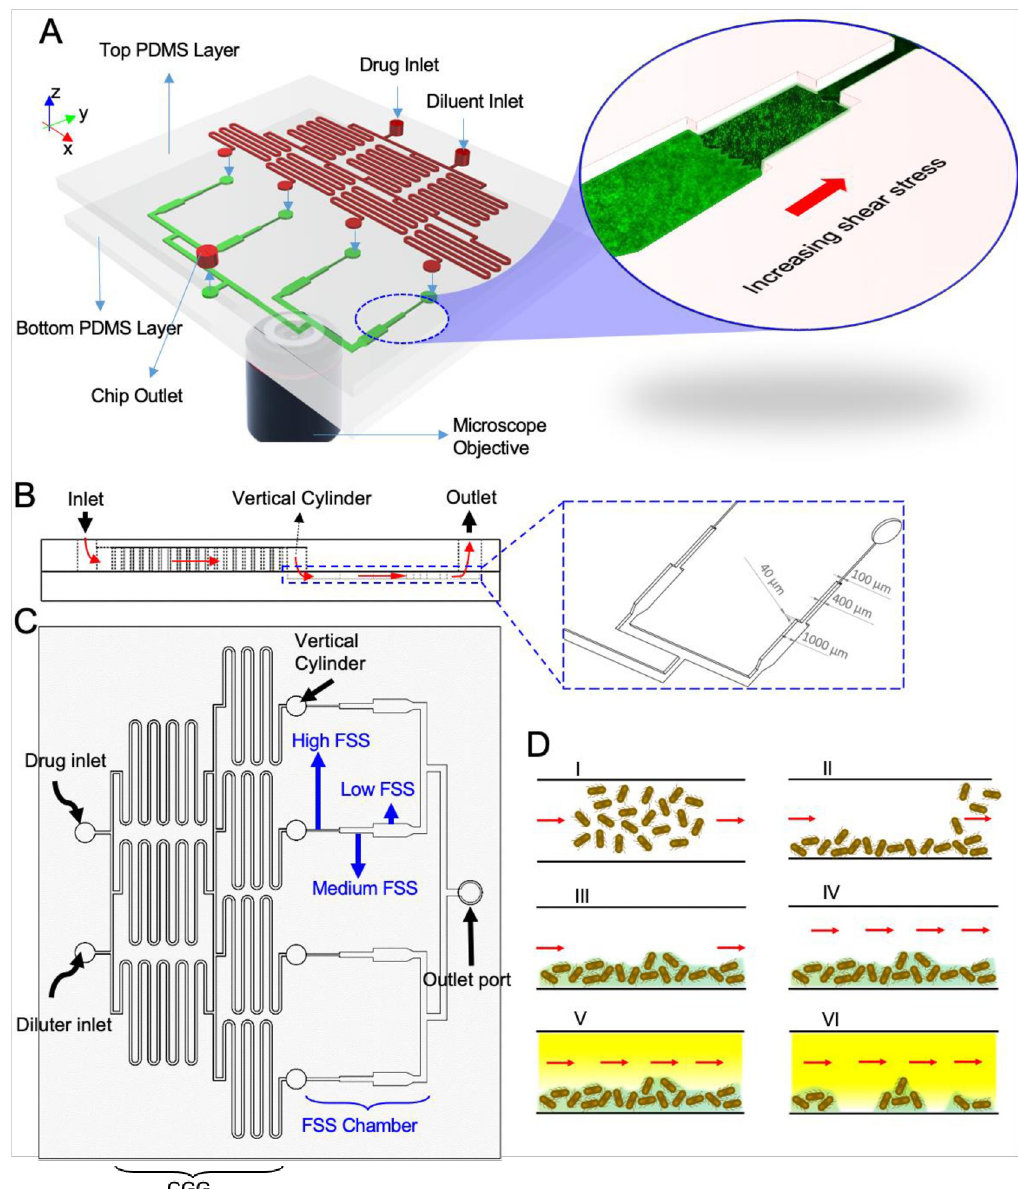
Fig 1. Integrated microfluidic platform allows investigation of combinatory effects of chemical and fluid shear stress (FSS). Ports and channels on the top layer are colored in red. Microchambers and collector channels on the bottom layer are colored in green. Vertical cylinders mediate the connection between the channels on the top and the bottom layer A) Schematic representation of the 2-layer physicochemical analysis biofilmchip (2PAB) B) Cross-sectional view of the platform with red arrows represent schematically the fluid flow streamline, and detailed dimensions of key features of the FSS chambers. C) Detailed schematic of the device with the concentration gradient generator (CGG) on the top layer providing stepwise antibiotic dilutions, and the FSS chambers on the bottom layer providing three zones of different shear stress levels in each chamber for testing on established biofilms. D) The workflow for biofilm formation and antibiotic/FSS treatment. Red arrows indicate the direction of fluid flow when